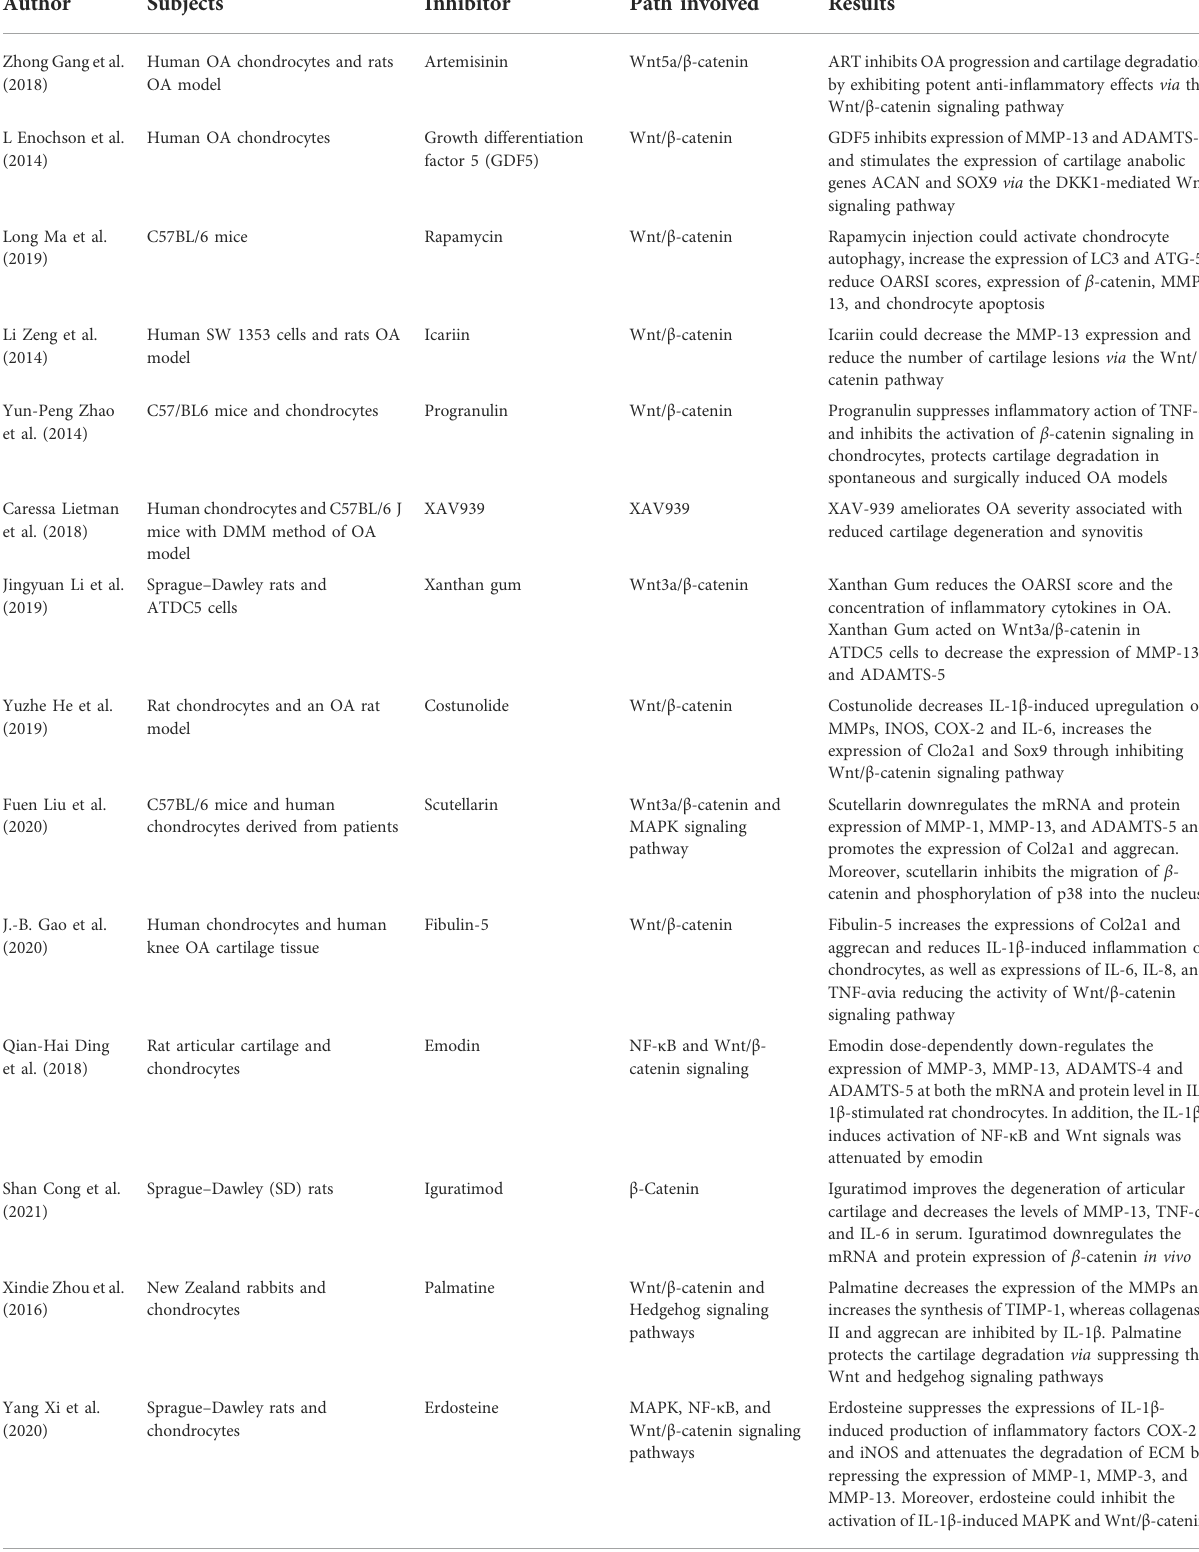
TABLE 5 Pharmacological inhibitors of the Wnt/ β -catenin signaling